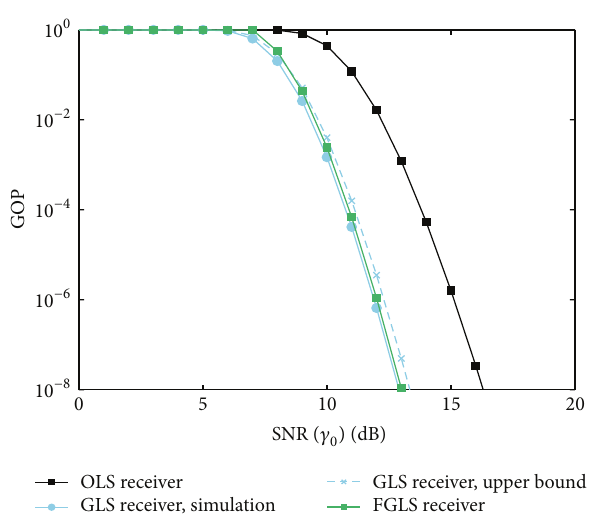
Figure 3: GOP versus SNR for target BER of 10 −4